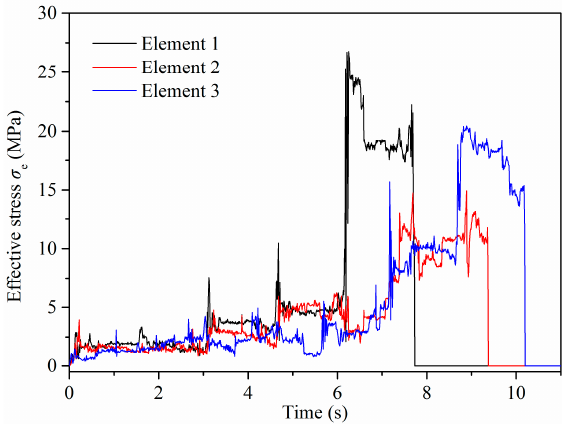
Figure 13. Effective stress of Elements 1, 2, and 3.